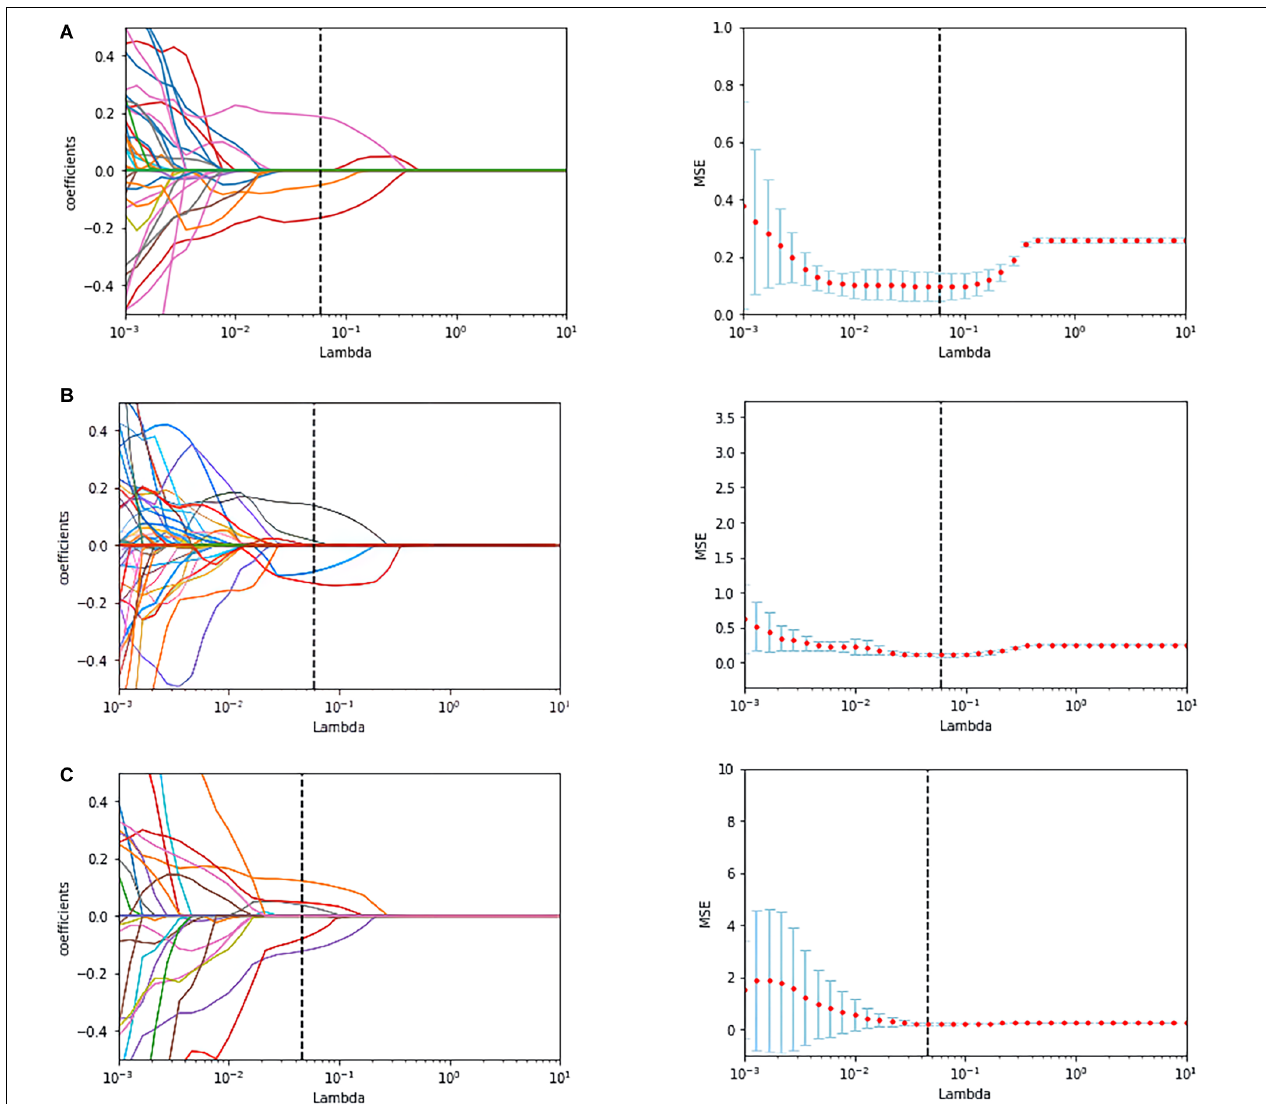
FIGURE 2 | The coefficients-lambda graph and the MSE-lambda graph (A) in the EOAD-YC groups, the LOAD-OC groups (B) , and the EOAD-LOAD groups (C) . MSE, mean-squared